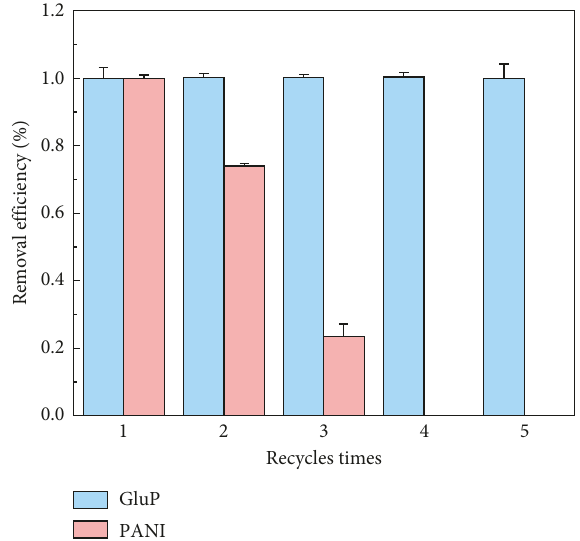
Figure 10: Recyclability study (0.5g/L absorbent, 30mg · L − 1 dye, pH 7, RT, t � 60